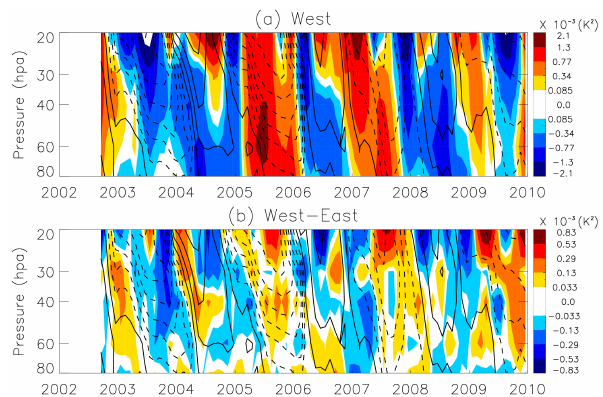
Fig. 9. Monthly mean timeseries (annual cycle and linear trend re- moved) of the zonally averaged GW variance taken at the westmost view (a) and the variance differences between the westmost and the eastmost view (b) . The vertical cross-section is taken at the equa- tor from 80hPa to 20hPa. 3-month running smooth window is ap- plied to the data to remove the sub-seasonal cycle. UKMO monthly mean zonal winds are overplotted in lines with contour intervals of 5ms − 1 and solid (dotted) lines indicating eastward (westward) winds. Variance within ± 0 . 085 × 10 − 3 K 2 and difference within ± 0 . 033 × 10 − 3 K 2 are